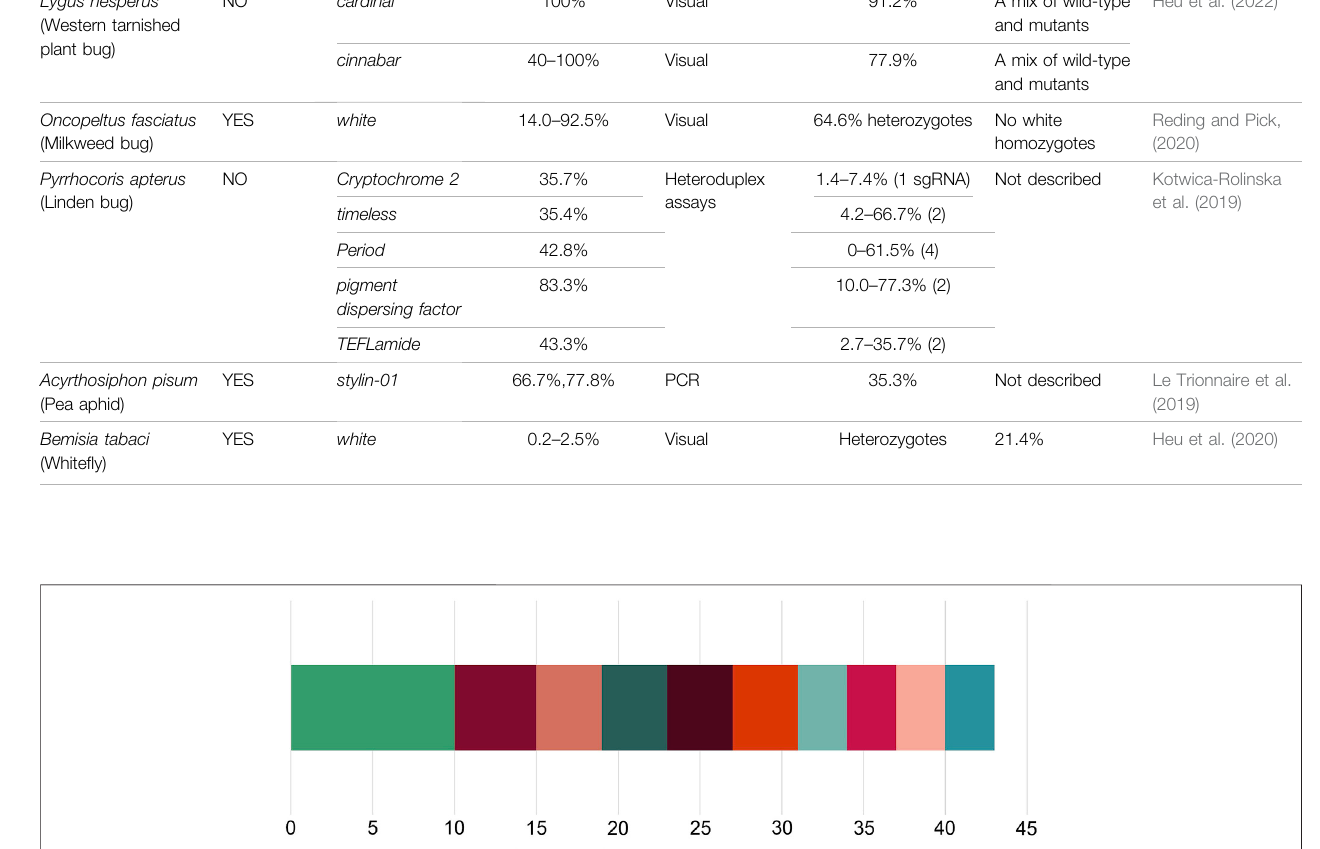
Frontiers in Bioengineering and Biotechnology |